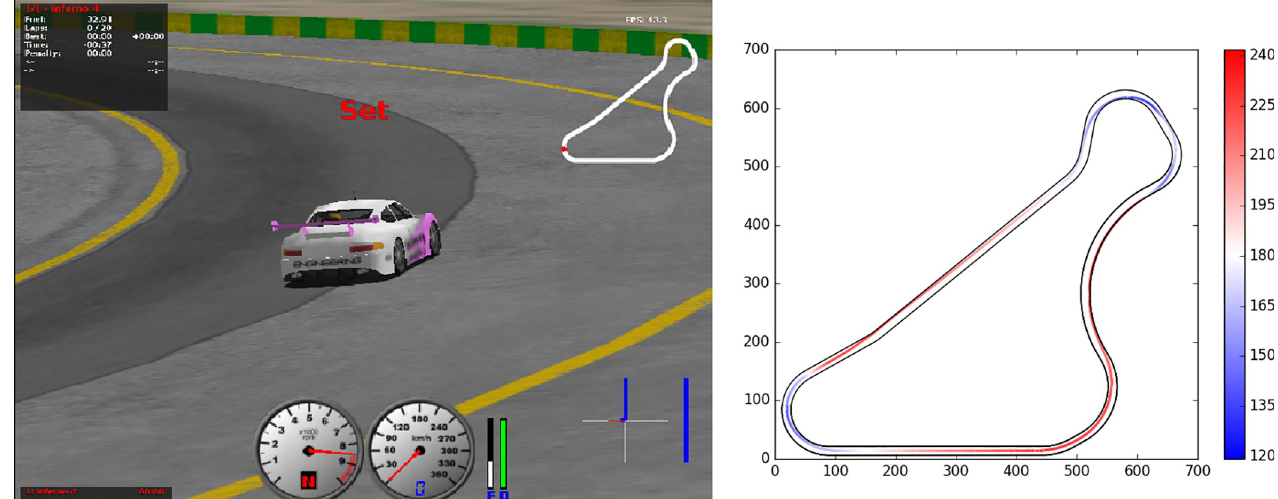
Fig 4. Left: A screenshot of the TORCS graphic render. Right: The CG-Track1 used in the experiments and the trajectory of the best evolved controller (see Section 5.2). The color indicates the speed in km/h during one lap of the circuit.